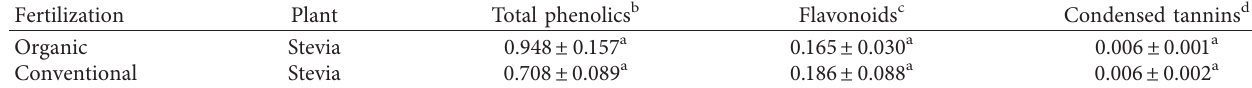
Table 1: Total phenolics, flavonoids, and condensed tannins in stevia a .